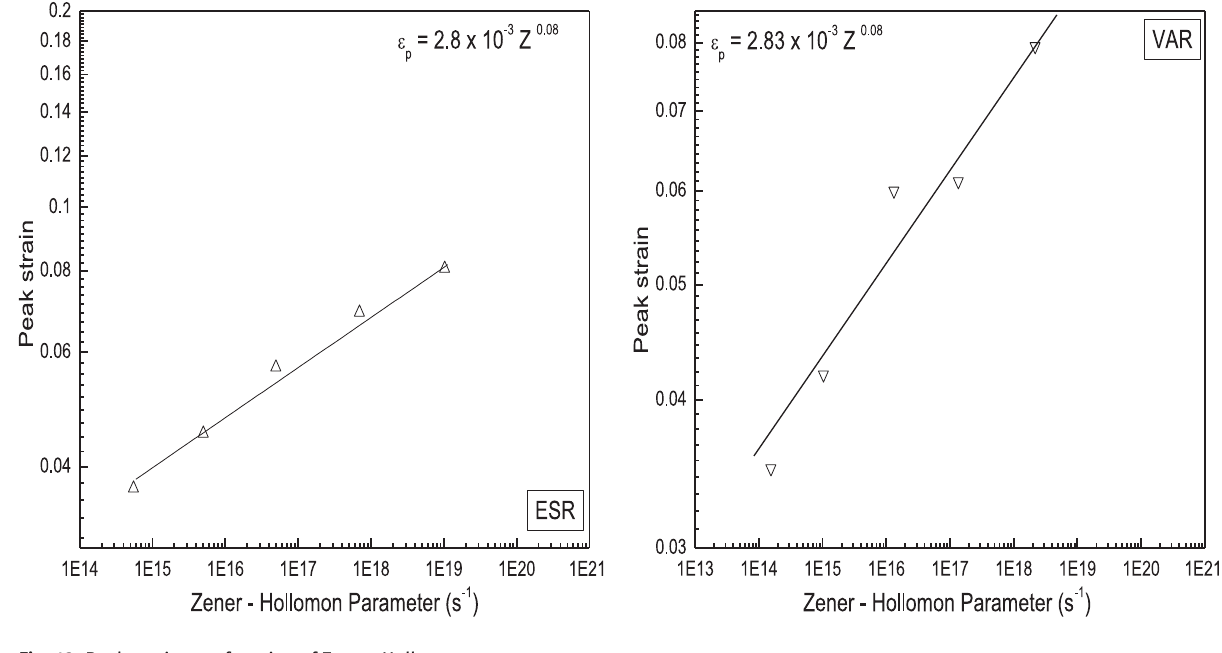
Fig. 12: Peak strain as a function of Zener–Hollomon